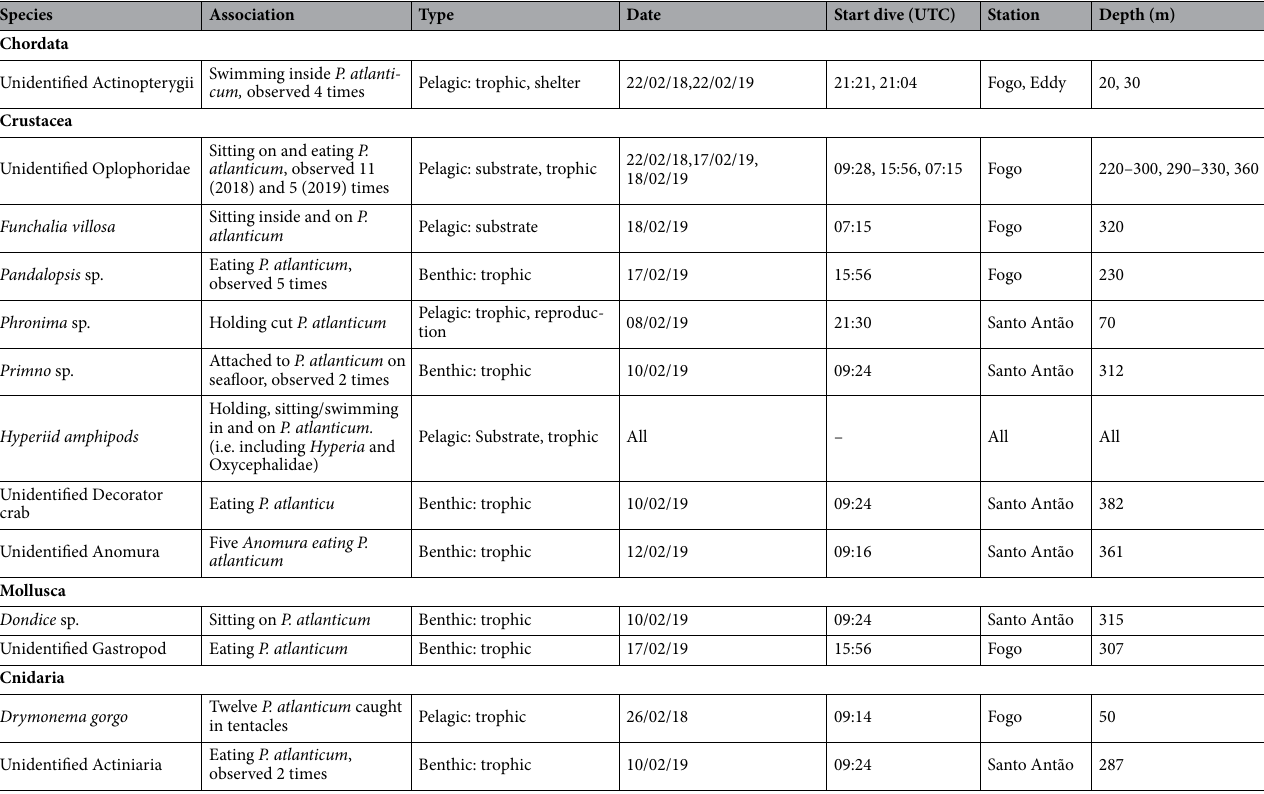
Table 1. Biological associations of P. atlanticum in the eastern tropical North